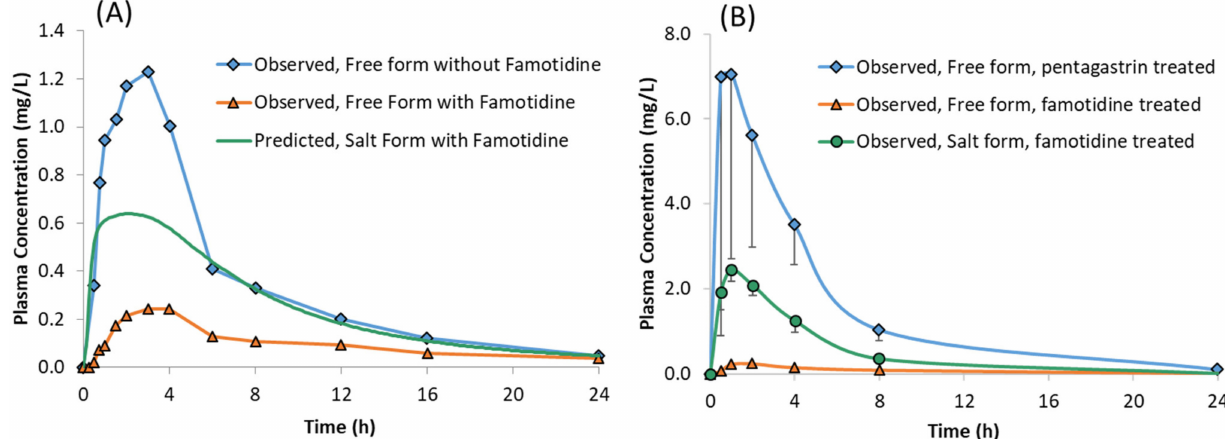
Figure 7. Plasma concentrations of model compound free form with and without famotidine and the salt form with famotidine in: ( A ) Healthy Human volunteers and ( B ) Male Beagle